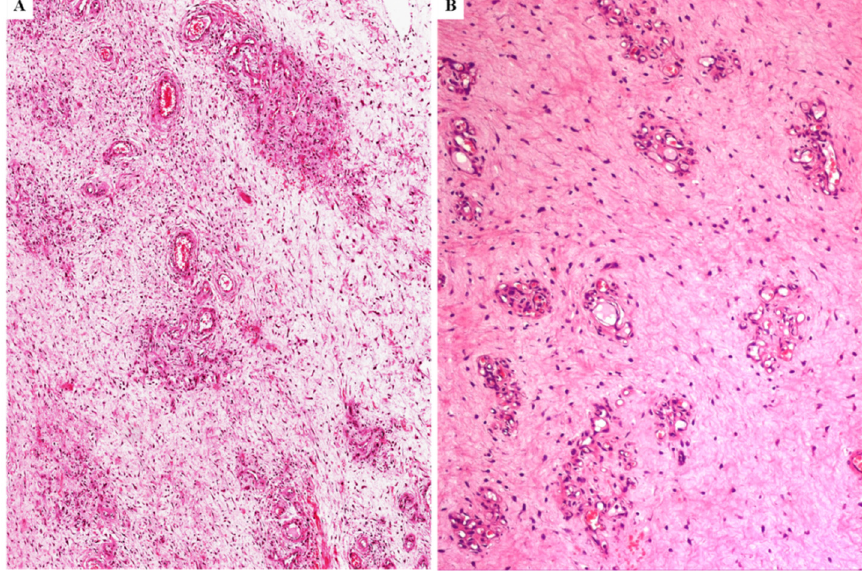
Figure 8. Microvascular growth pattern in primary DAM . Two different DAMs ( A , B ) in which the vascular component is mainly composed of closely packed capillary-sized blood vessels; this growth pattern is reminiscent of the so-called “ microvascular pattern ” as seen in glioblastoma. In (vi) one case, there was a small-sized nodule (0.5 cm) composed of spindled cells with eosinophilic cytoplasm and ovoid nuclei containing one small nucleolus with the typical features of classic-type DAM; the cells, which are stained with vimentin, desmin, smooth muscle actin and h-caldesmon, were arranged in fascicles separated by scarce fibrous stroma and contained capillary-like blood vessels (Figure 9).